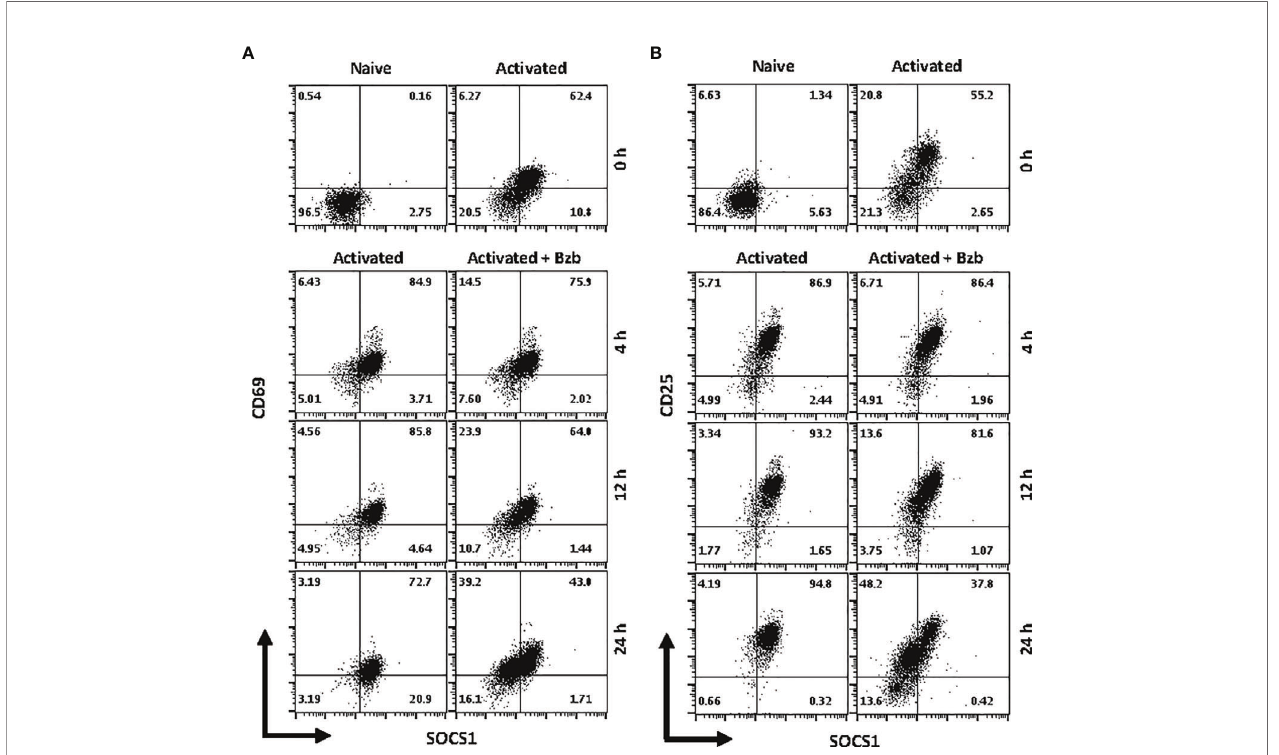
FIGURE 8 | Bortezomib decreases suppressor of cytokine signaling 1 (SOCS1) protein levels in primary activated CD8 + T cells. CD8 + T cells were puri fi ed from the spleen and lymph nodes of naïve BALB/c wild-type (WT) mice. Cells were stimulated in vitro with soluble anti-mouse CD3 and CD28 antibodies (1 µg/ml each) for ~20 h followed by treatment with 10 nM bortezomib for 4, 12, and 24 h. With each time point, surface staining for CD8, CD69, and CD25 as well as intracellular staining for SOCS1 and SH-2 containing inositol 5 ’ -polyphosphatase 1 (SHIP1) was performed. Dot plots depict percentages of CD8 + cells that express both SOCS1 and CD69 (A) or SOCS1 and CD25 (B) in the naïve, activated, and activated plus bortezomib-treated groups. Plots are representative of three independent